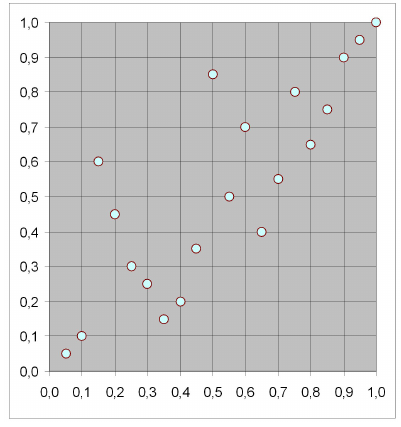
Figure 15: Relative ranks r · i /20 Figure 16: "Worst case" shuffle of M